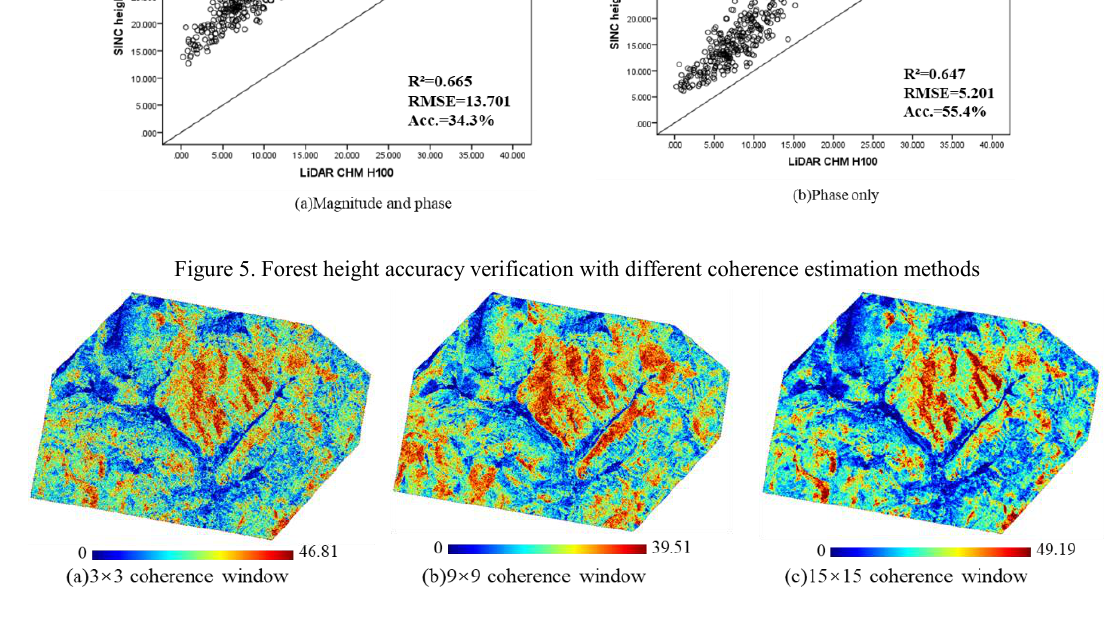
Figure 6. Forest height estimation results with different window